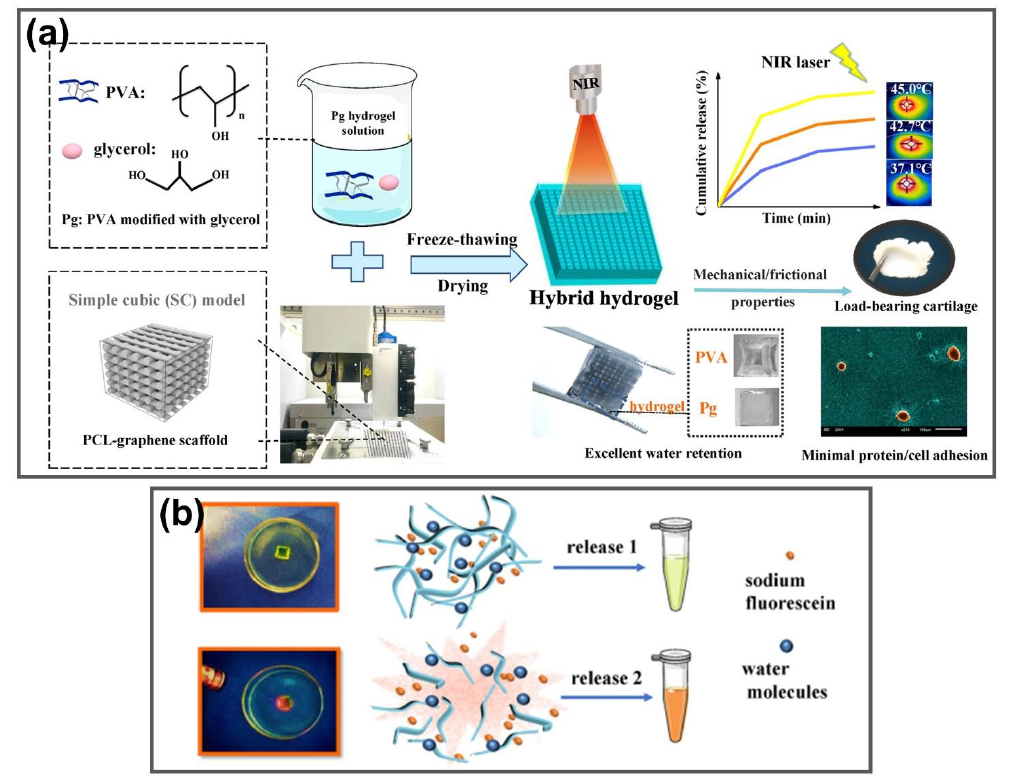
Figure 6. GGels for NIR-responsive drug delivery systems in anticancer treatment. ( a ) Schematic illustration of the fabrication and characteristics of PG-Pg hybrid hydrogels. ( b ) Drug release mechanism of PG-Pg hydrogels without and with NIR irradiation. Adapted with permission from [116] .